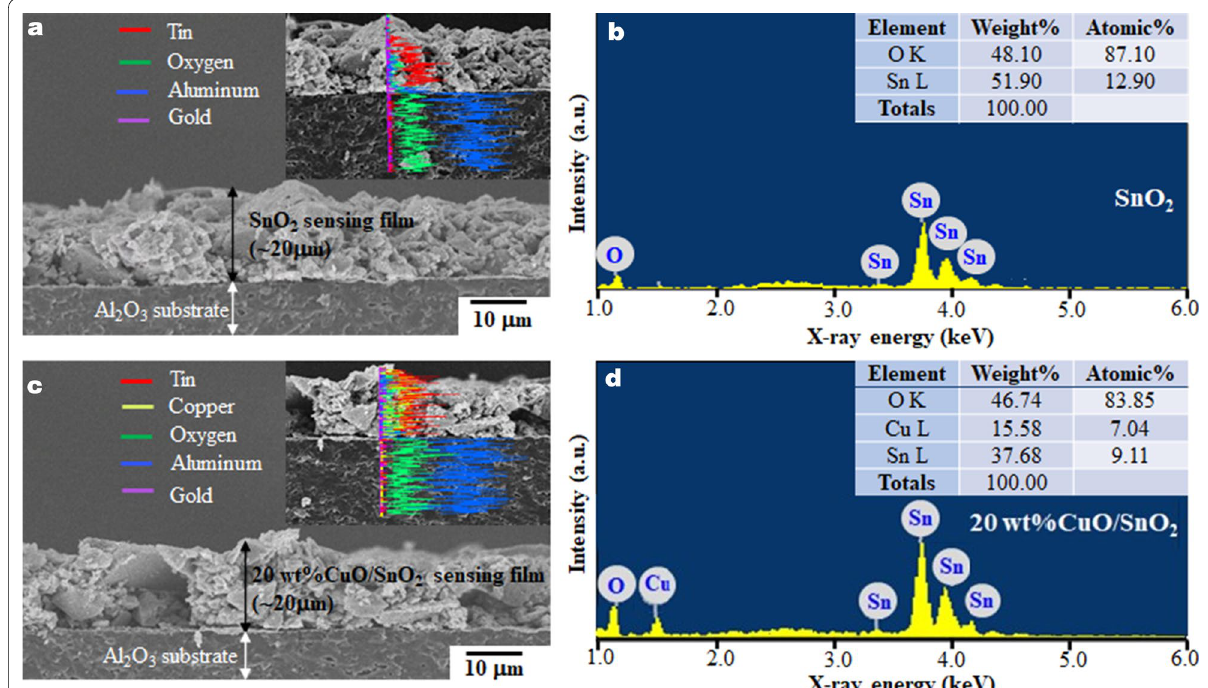
Fig. 6 Cross-sectional FE-SEM images with EDS line-scan profiles (inset) and corresponding EDS spectra with elemental composition tables (inset) of the a , b SnO 2, and c , d 20 wt%CuO/SnO 2 NPs sensing